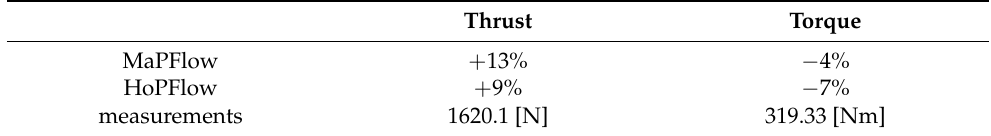
Table 7. Thrust (N) and Torque (Nm) estimation. Comparison between computational predictions and experimental measurements. Reference values correspond to measured values.